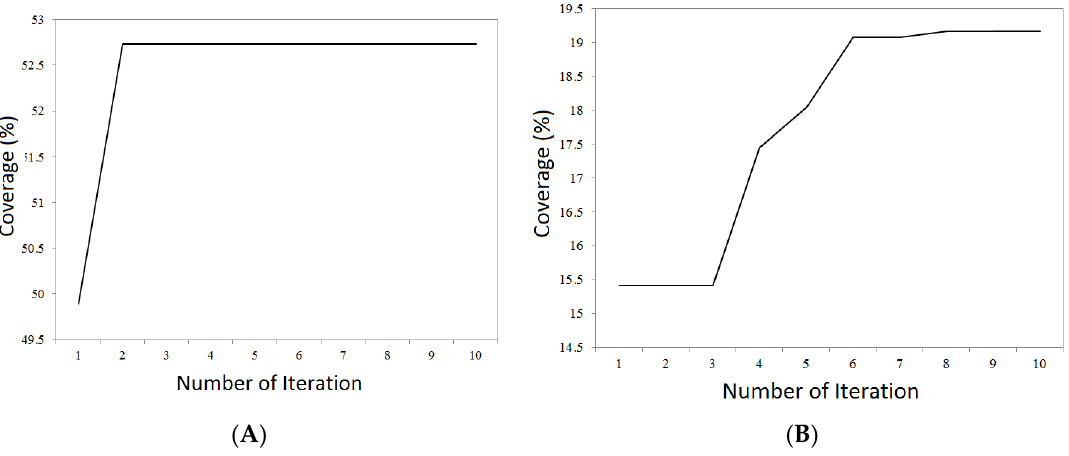
Figure 16. Convergence diagram based on VFCPSO algorithm for: ( A ) two-dimensional; and ( B ) three-dimensional raster models.